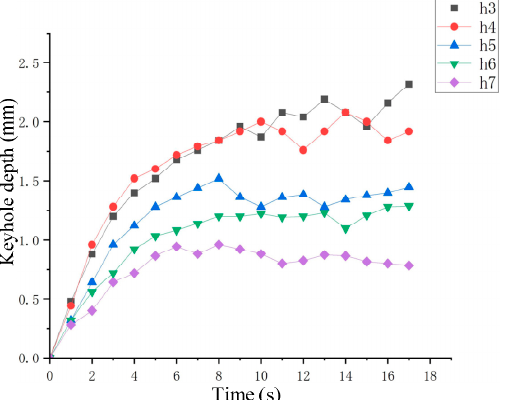
Figure 9. Effect of distance between nozzle outlet and liquid level on keyhole depth.